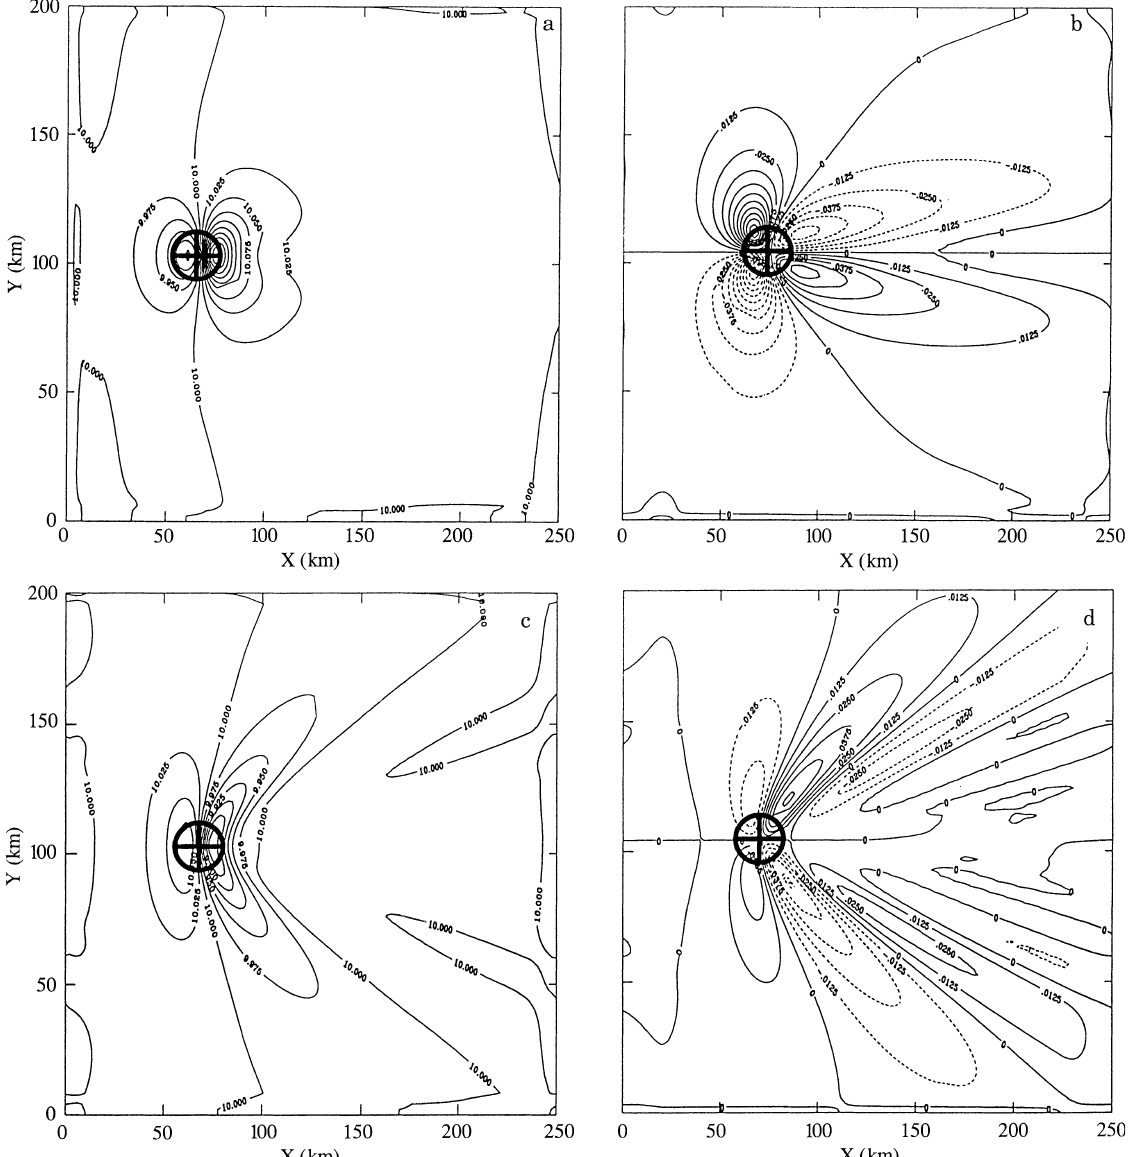
Fig. 12a–d. Results of the control simulation for 3D linear, hydrostatic mountain waves. The cross shows the position of the mountain. The fields shown are the u component of velocity at a 250m and c 3000m altitude, and the v component of velocity at b 250m and d 3000m. Contour intervals are 0 : 025ms (cid:255) 1 for u and 0 : 0125ms (cid:255) 1 for